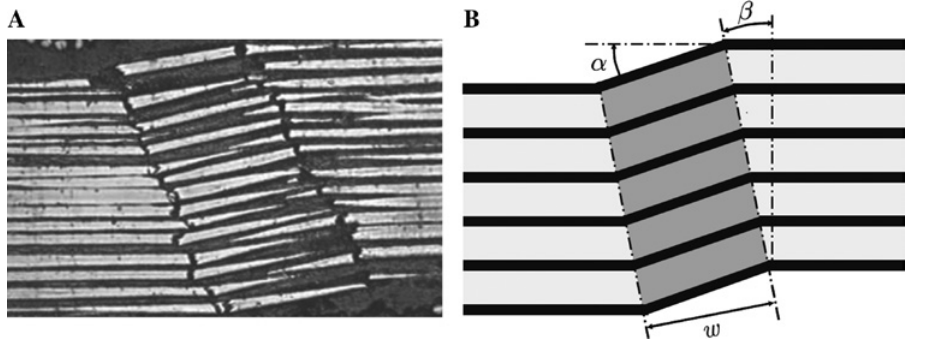
Figure 1: The definition of a kink band. (A) Micrograph from experiment in Ref. [7]. (B) Schematics and definition of the kink-band geometric parameters: fiber angle α , band angle β , and band width ω